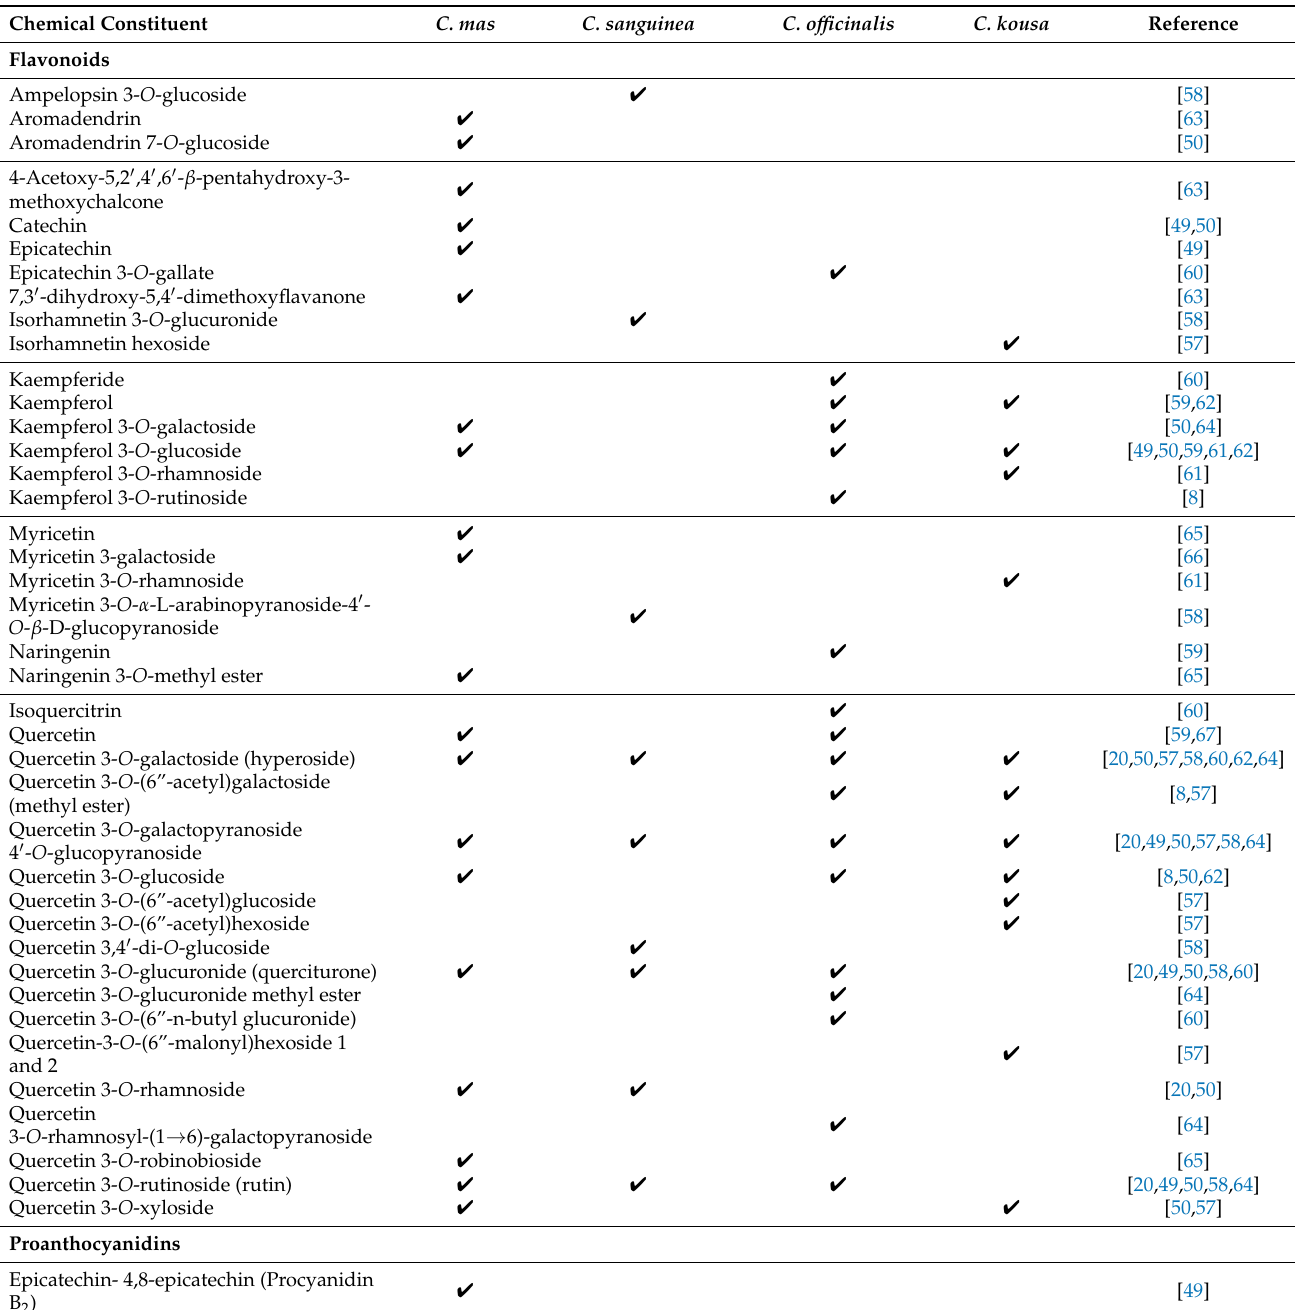
Table 2. The main flavonoids and proanthocyanidins of Cornus